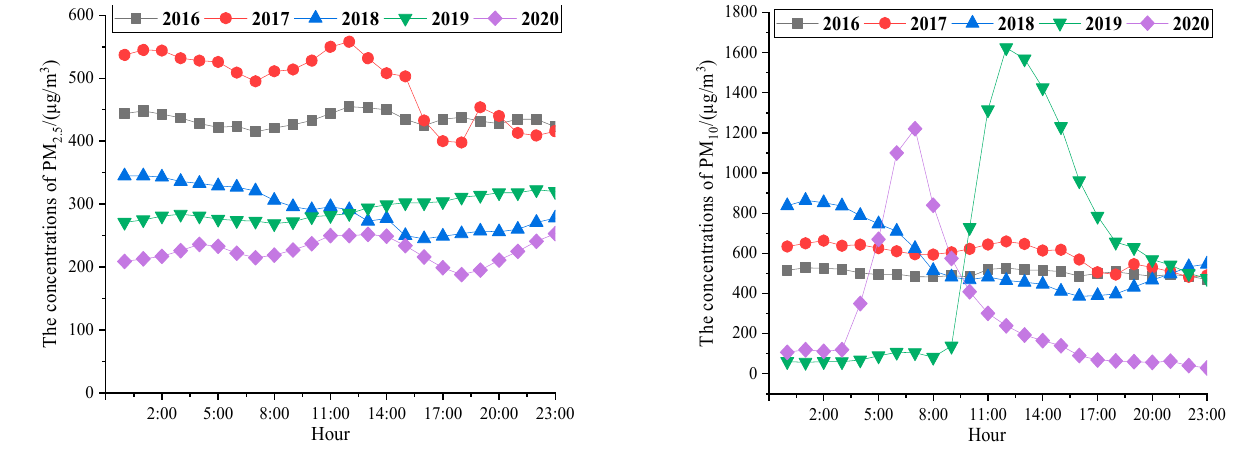
Figure 4. Daily changes in PM 2.5 and PM 10 concentrations from 2016 to 2020. Table 2. Statistics of PM 10 and PM 2.5 on typical days from 2016 to